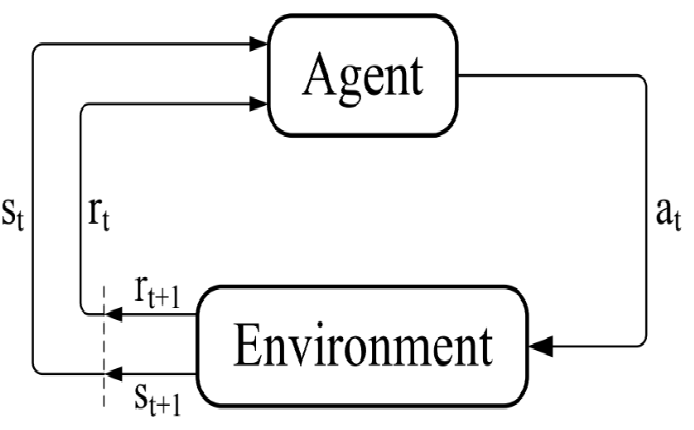
Figure 1. RL framework. Adapted from